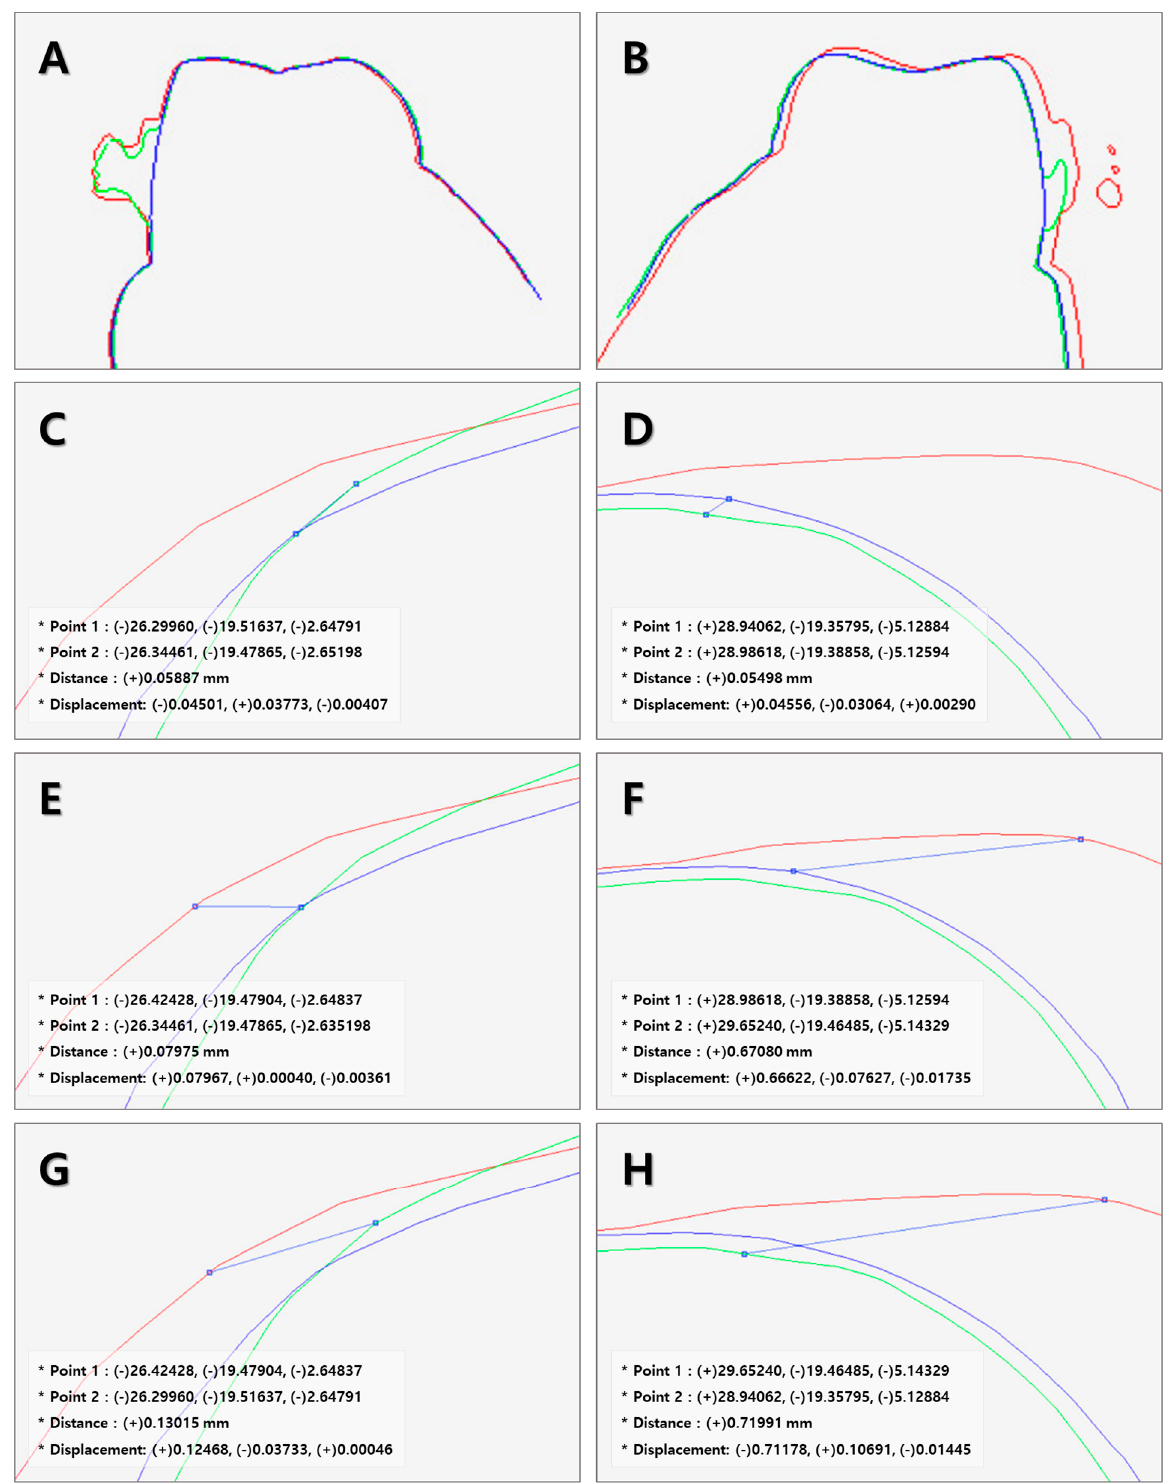
Figure 3. The deviation of the measured model with Rapidform 2004 TM . Blue line = control group, green line = MB group, red line = CB group. ( A , B ) 2D cross-section of first molar mesiobuccal cusp, ( C , D ) distance between the control group and MB group on first molar mesiobuccal cusp, ( E , F ) distance between the control group and CB group on first molar mesiobuccal cusp, and ( G , H ) distance between MB group and CB group on first molar mesiobuccal cusp.